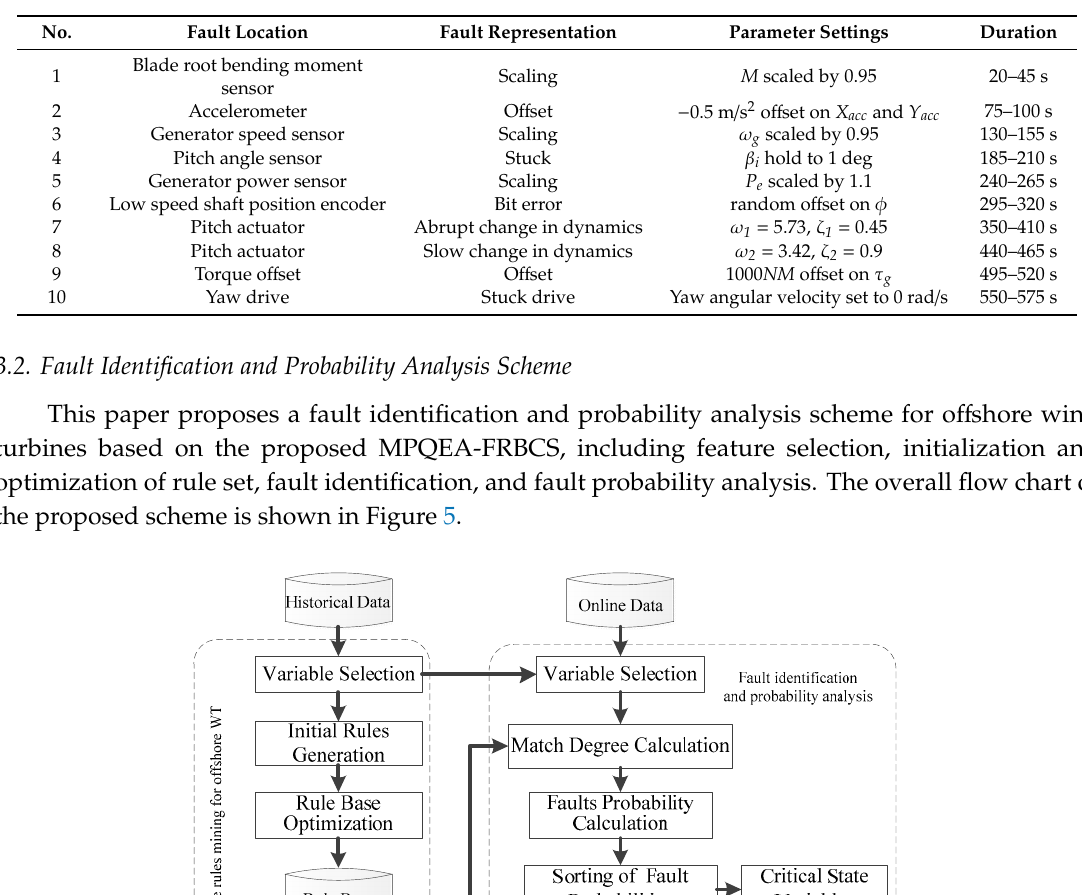
Figure 4. The sensor positions in the WT model. Table 3. The instructions of fault generation.